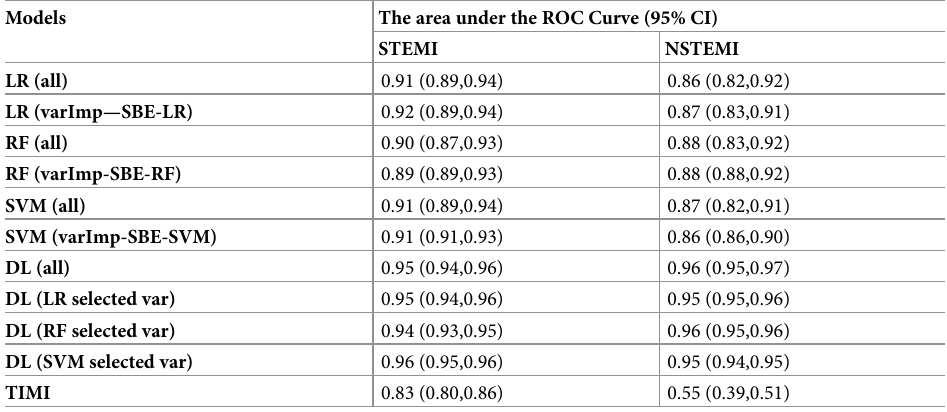
Table 4. The AUC of TIMI risk score, DL and ML models with and without feature selection based on a 30% vali- dation dataset.